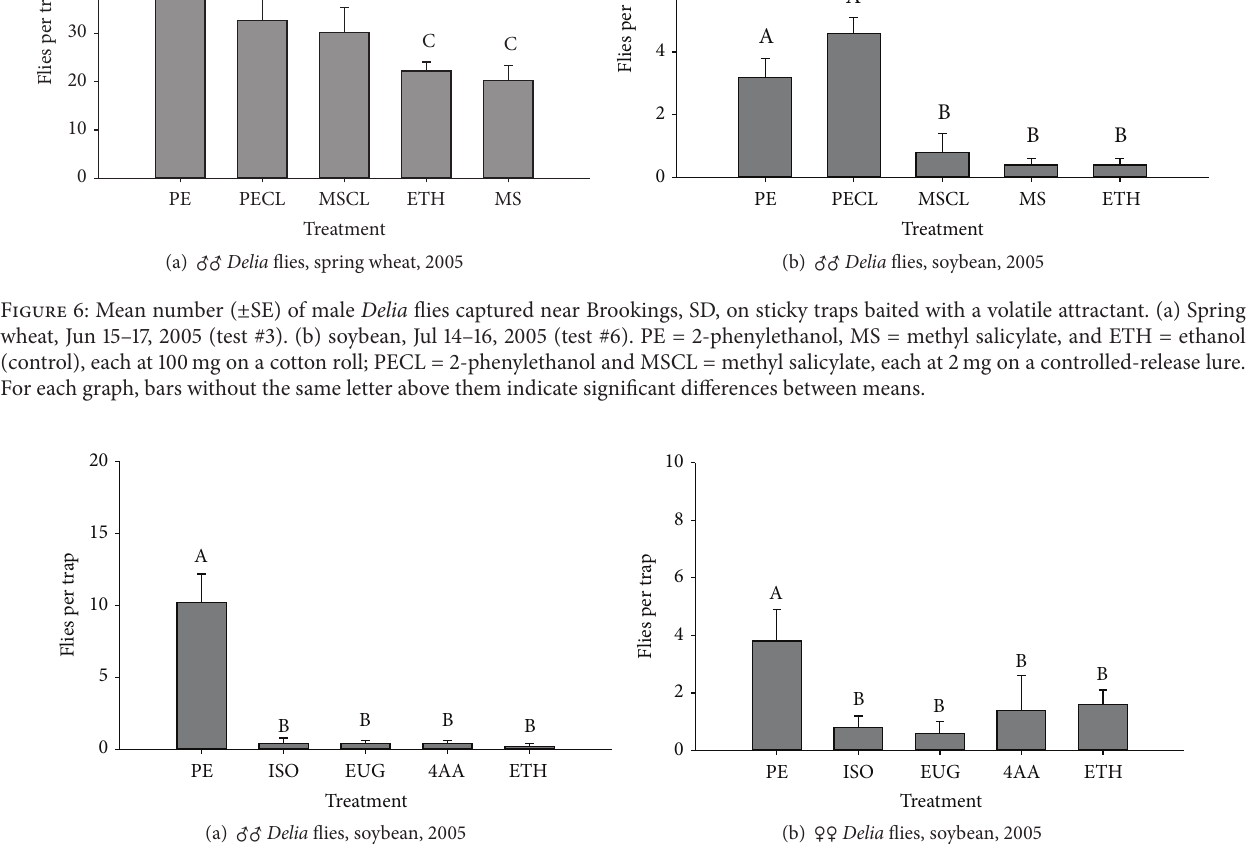
may indicate suitable larval habitat to ovipositing